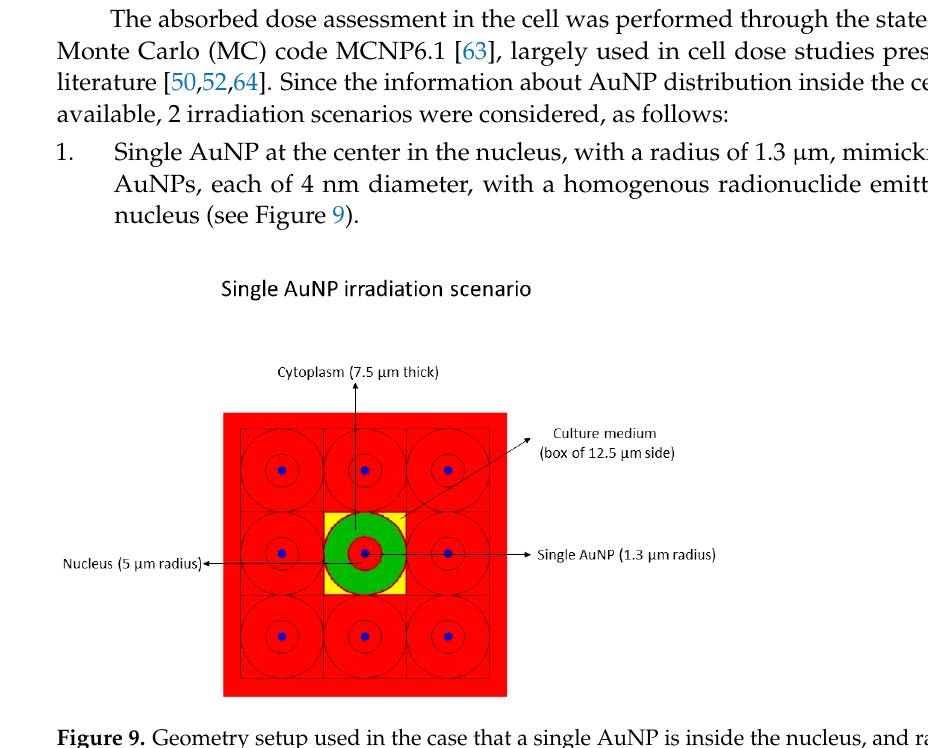
Figure 9. Geometry setup used in the case that a single AuNP is inside the nucleus, and radionuclide emitting homogeneously in the nucleus.